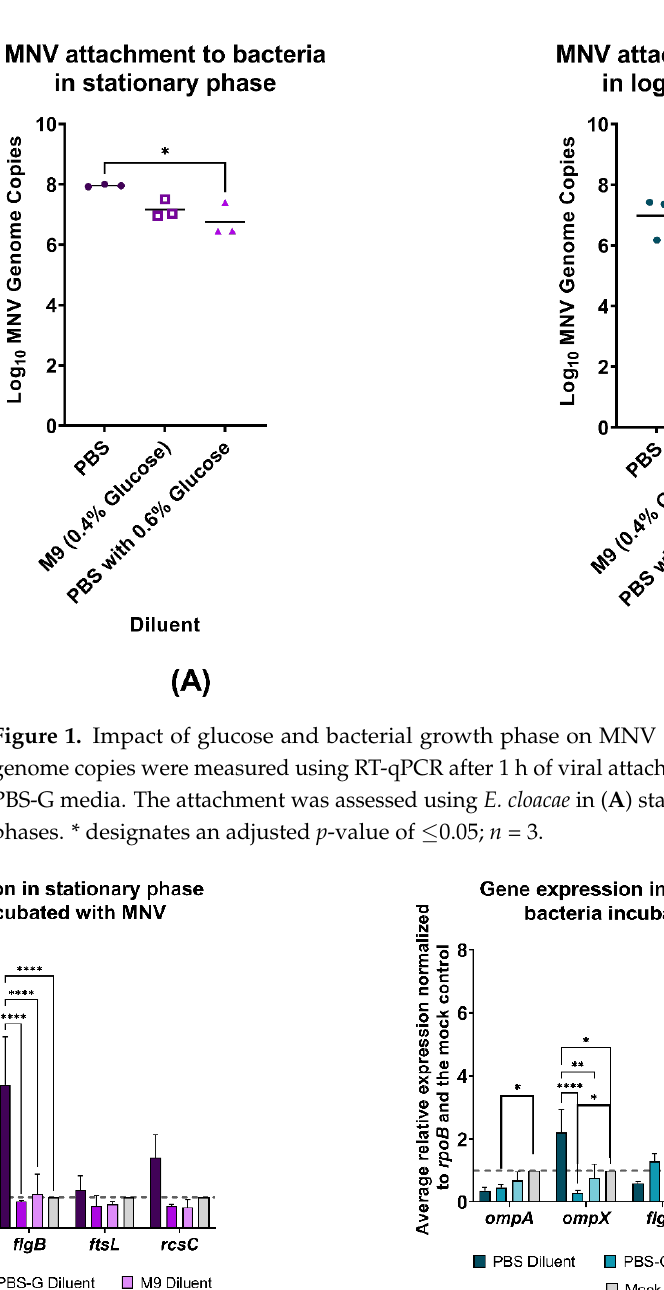
Figure 2. Growth phase results in the difference in gene expression when murine norovirus is attached to E. cloacae . ( A ) Differences in gene expression measured via qPCR when MNV interacts with E. cloacae at stationary growth phase; ( B ) differences in gene expression measured via qPCR when MNV interacts with E. cloacae at mid-log growth phase. Relative expression and significance are measured against gene expression of a mock control of E. cloacae without MNV, signified by a dashed line at y = 1 and the mock control column. * designates an adjusted p -value of ≤ 0.05, ** ≤ 0.01, *** ≤ 0.001, **** ≤ 0.0001 and the error bars show SEM; n = 3.